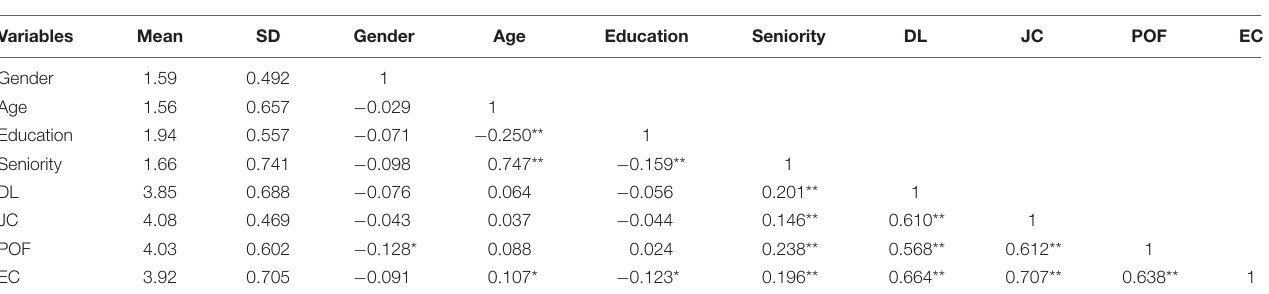
TABLE 2 | Means, standard deviations (SD), and